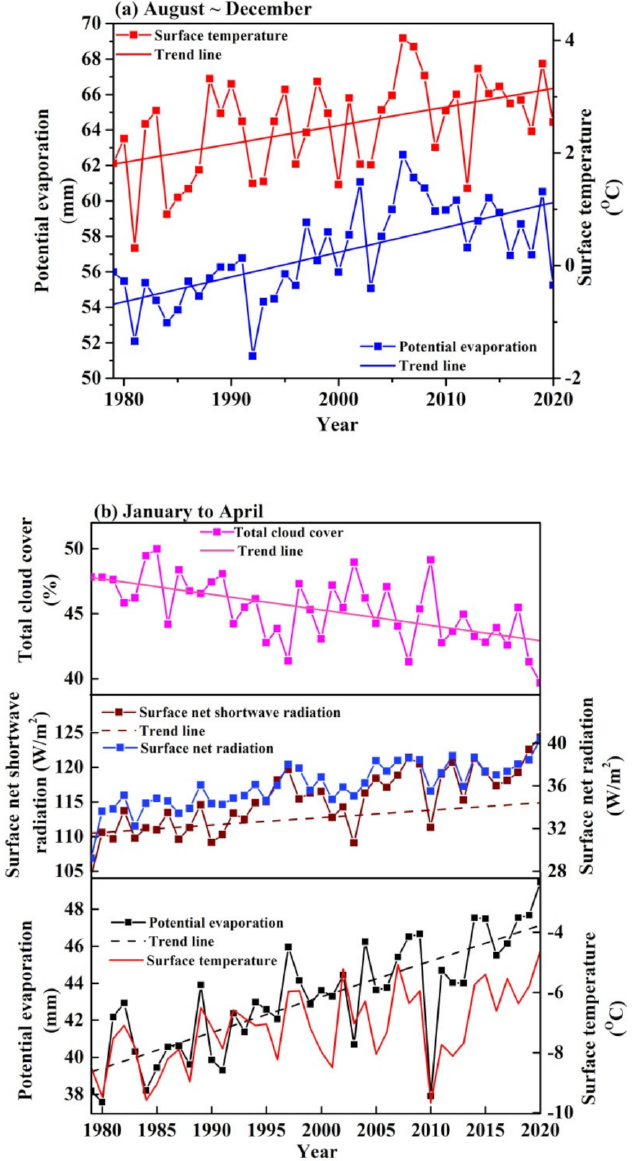
Figure 4. Temporal distribution of key monthly mean energy cycle parameters during the